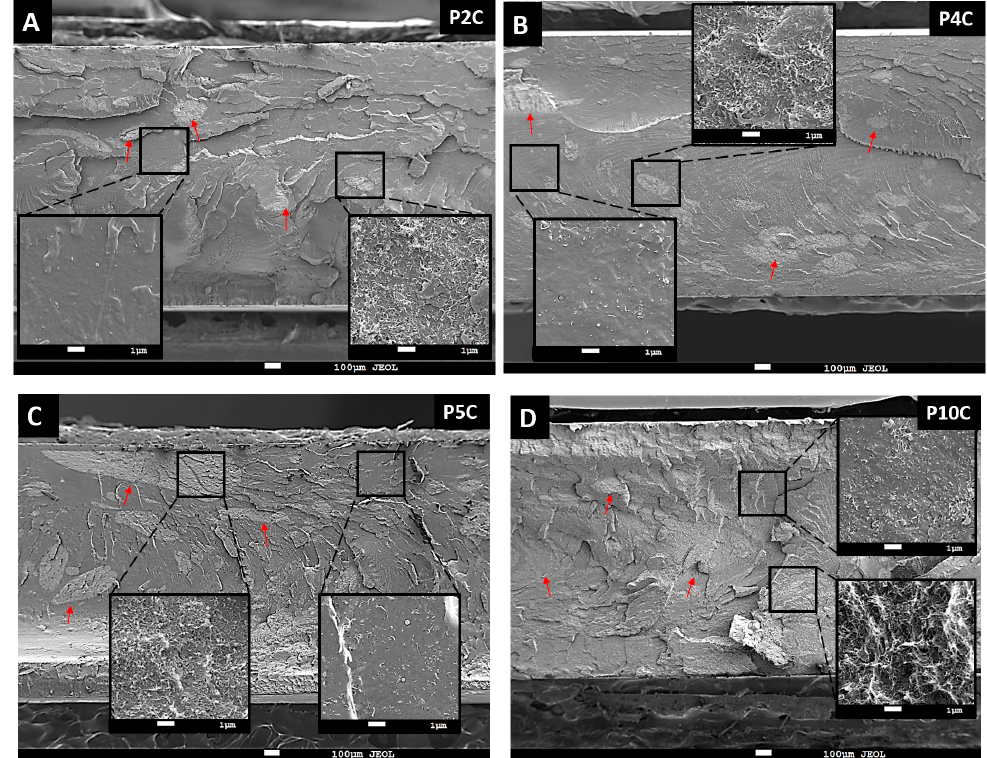
Figure 3. SEM micrographs of injected samples of PLA with ( A ) 2, ( B ) 4, ( C ) 5 and ( D ) 10 percent of MWCNT, amplitude × 40 and inset × 5000.